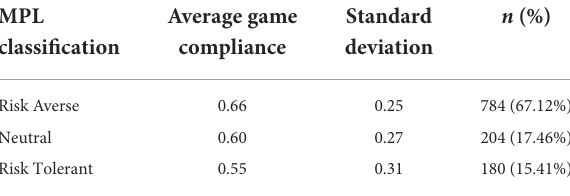
FIGURE3 Violin plots showing risk distributions calculated for each experimental game treatment: probability of infection ( p inf ) and disease information uncertainty. The overall risk observed from the full simulation (i.e., all experimental scenarios) as well as the MPL calculated risk are given in the final violin plots.